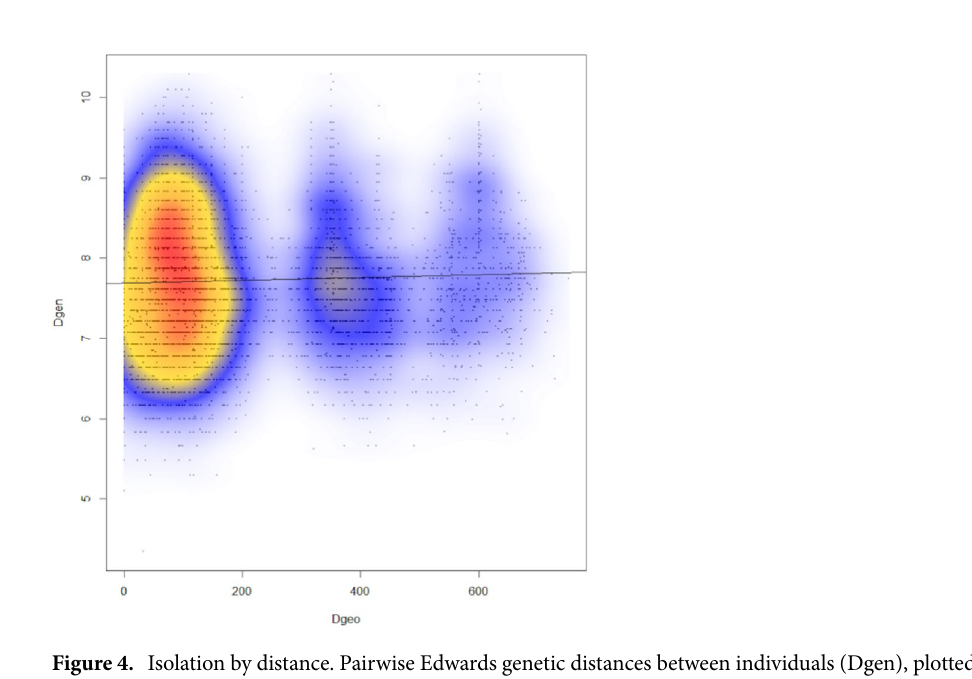
Table 3. Hierarchical analysis of molecular variance (AMOVA) based on microsatellite data for European wildcat populations. Values in bold are significant (P < 0.001). The populations correspond to four populations defined by country (according to Table 4), groups correspond to the two clusters according to the result of FCA and STRU CTU RE analysis (K = 2). P values are given in parenthesis.